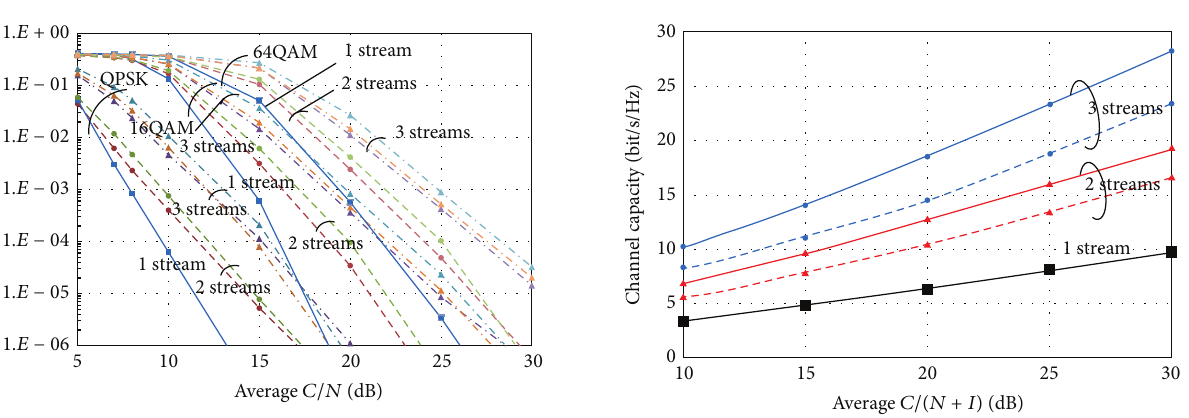
Figure 2: BER performance in accordance with modulation schemes and number of streams.